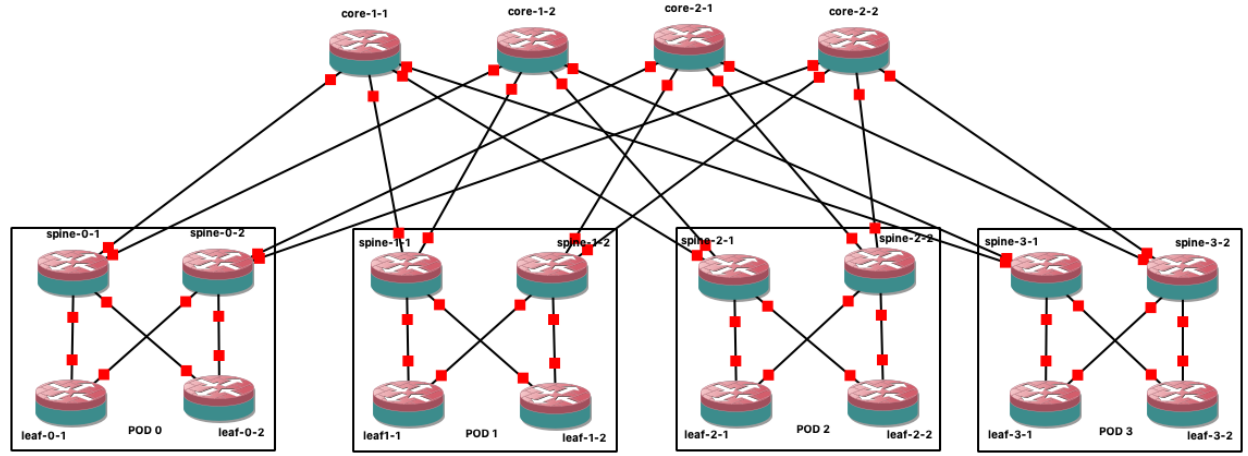
Figure 3. A fat-tree build with